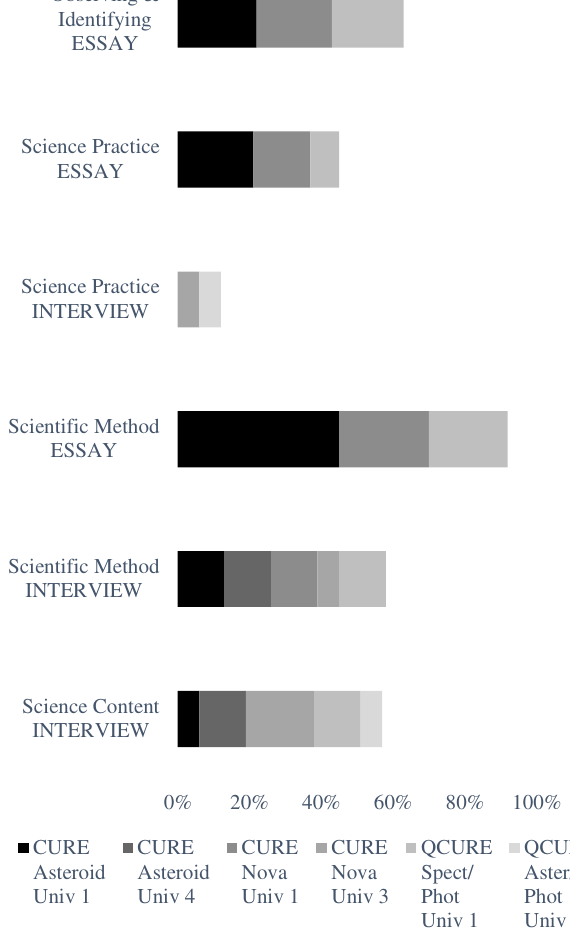
FIG. 5. Percentage of responses represented within each theme regarding the category of previous science learning, shaded by course type, project, and institution. Themes were generated from qualitative analyses of students ’ preinstruction essay ( n ¼ 76 out of 94) responses and interview ( n ¼ 16 out of 19) and are shaded by course type, project, and